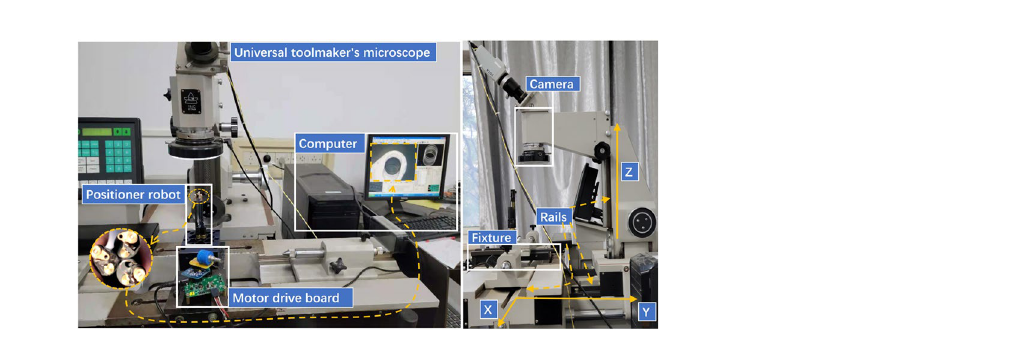
Figure 19. Positioning experiment